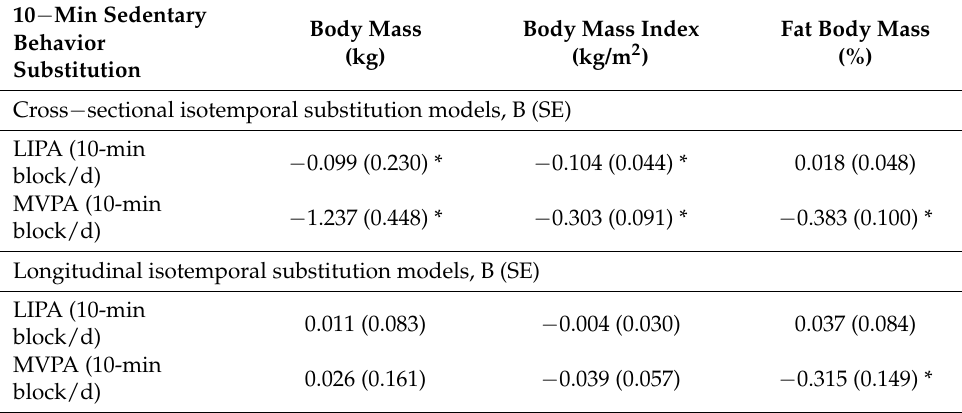
Table 4. Effects of replacing sedentary behavior with light and moderate-to-vigorous physical activity on obesity